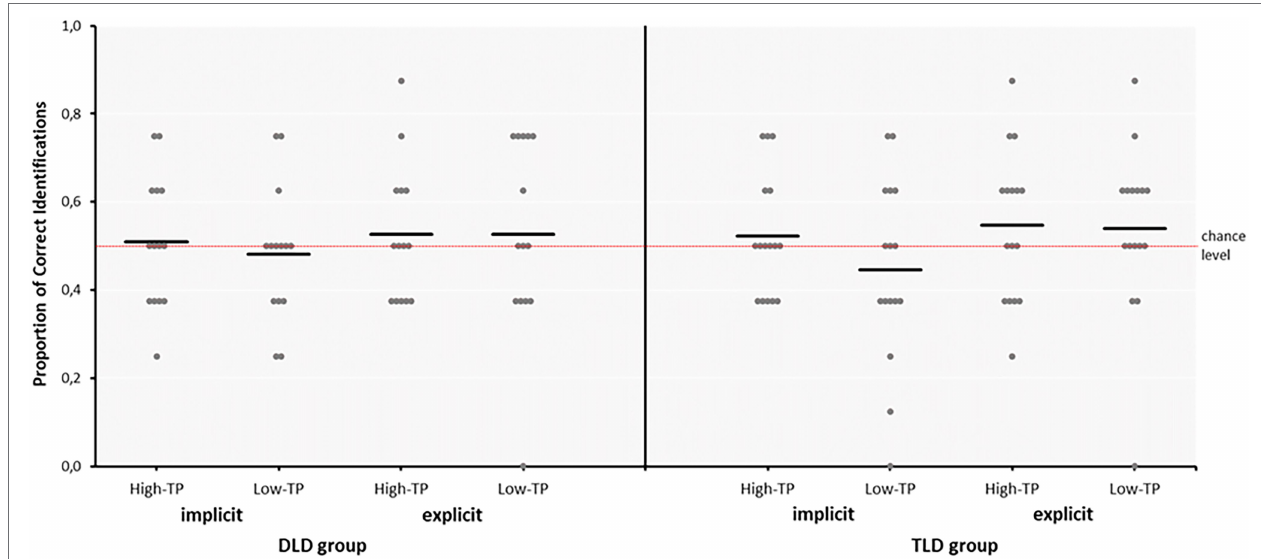
FIGURE 3 | Accuracy Rates (Proportion of Correct Identifications) in the 2-AFC Tasks Performed under Implicit and Explicit Conditions for the high- and low-TP “Words” in the DLD and TLD Groups. DLD, developmental language disorder group; TLD, typical language development group. The dots represent the scores obtained by each participant in each of the conditions (aSL task and type of “word”) per group (DLD and TLD) while the horizontal black solid lines in each of these cases represent the mean of the group in each of these